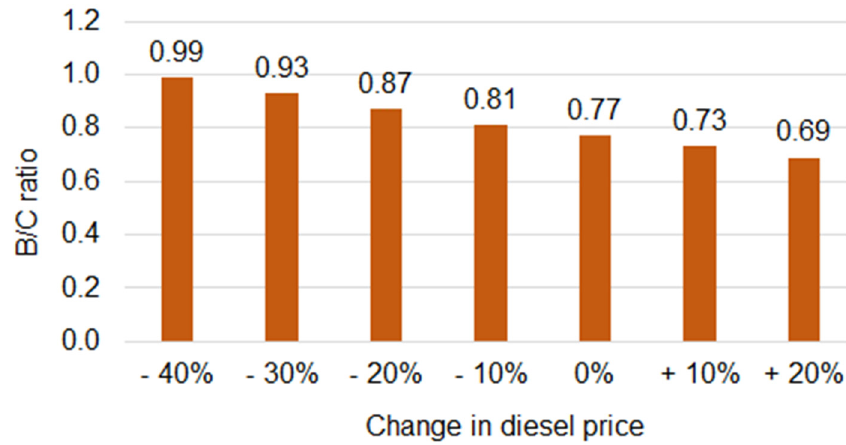
Figure 9. Effect of crop selling price changes to B/C ratio, case diesel.